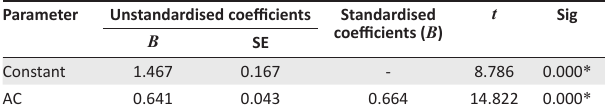
TABLE 6: Parameter estimates for the knowledge sharing on small and medium enterprises’ absorptive capacity model. Parameter Unstandardised coefficients